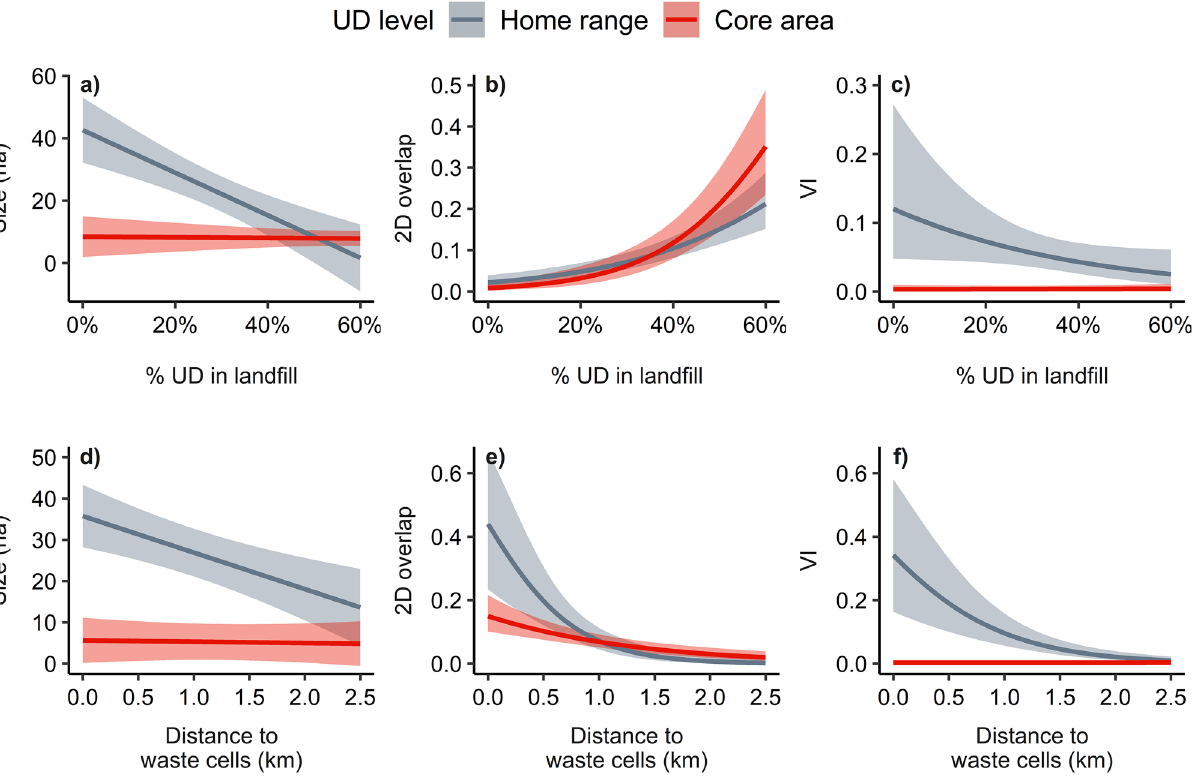
Figure 3. Predicted effects of percentage of utilization distribution (UD) in the landfill (% UD in landfill) and distance from UD boundaries to the waste cells within the landfill (Distance to waste cell [km]) on UD size (ha; a and d ), proportional area of overlap (2D overlap; b and e ), and volume of intersection (VI; c and f ) of season- long ( n = 2) UDs for wild pigs ( Sus scrofa ; n = 14) on Savannah River Site, South Carolina, USA, in 2014 and 2016. Figure created in the R statistical environment version 4.0.5 (https:// www. cran.r- proje ct. org) 27